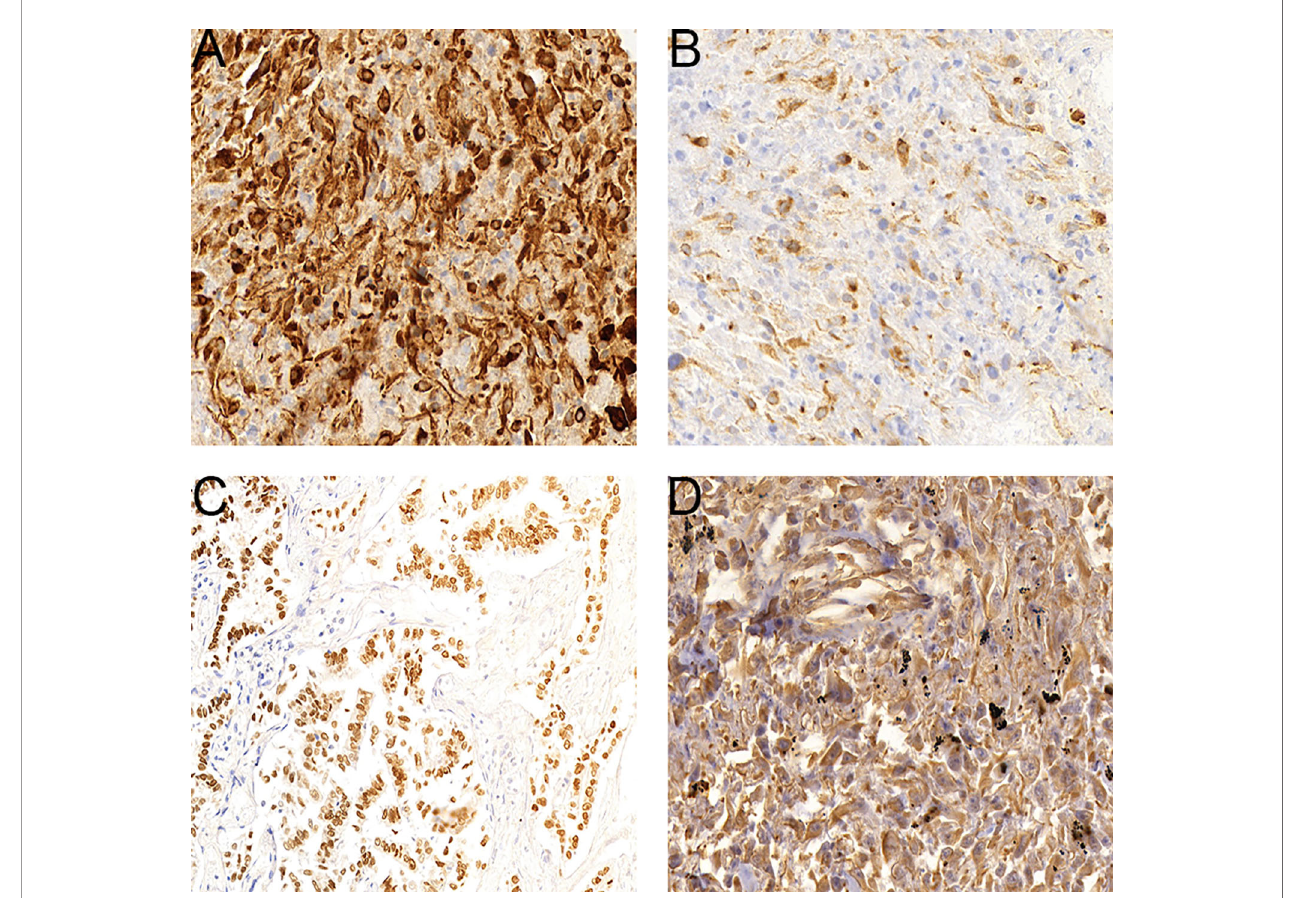
FIGURE 2 | Expression levels of select genes in PSC tumors. (A) , CK-positive staining cells in a sarcomatoid carcinoma. (B) , CK7-positive staining cells in a sarcomatoid carcinoma. (C) , TTF-1-positive staining cells in a sarcomatoid carcinoma. (D) , Vim-positive staining cells in a sarcomatoid